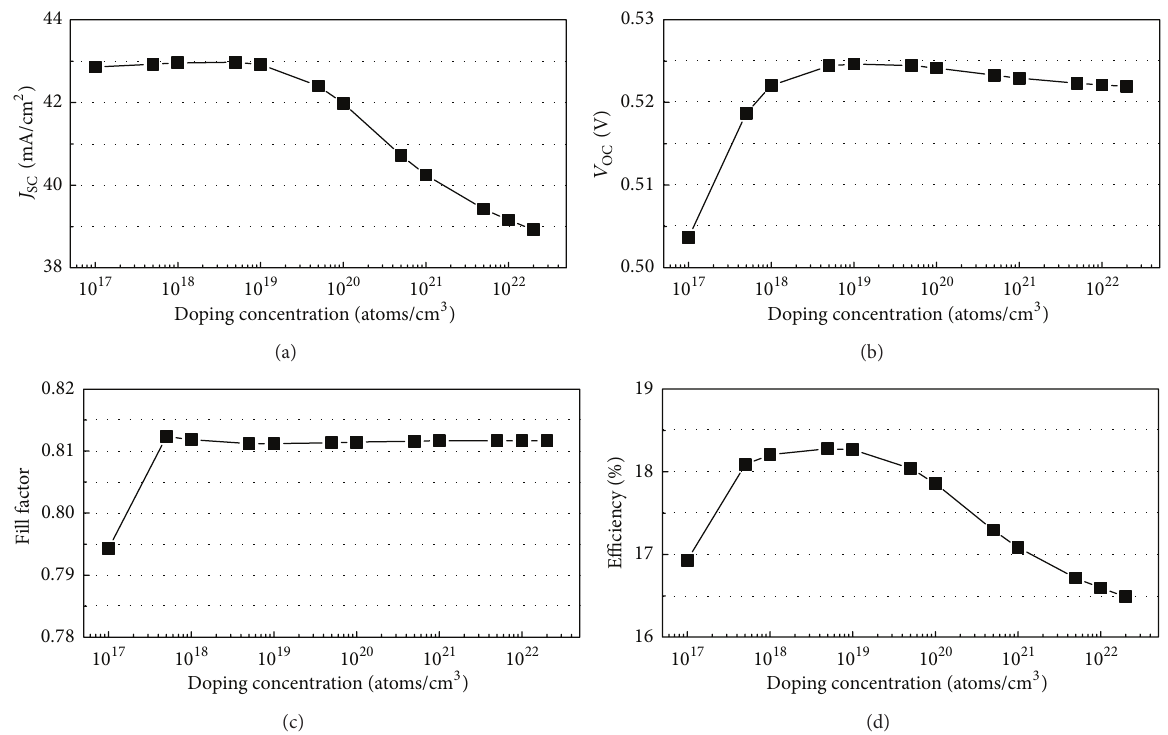
Figure 2: Dependence of the output parameters: (a) short circuit current density, (b) open circuit voltage, (c) fill factor, and (d) efficiency of the cell, on the boron concentration.